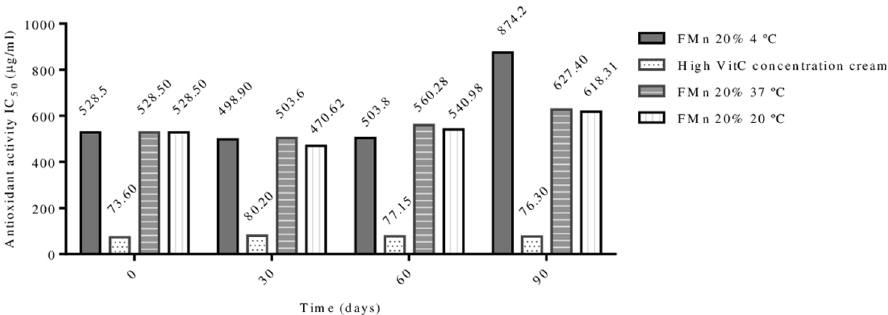
Figure 5. Mean values and standard deviations (Mean ± SD) (number of observations, n = 3) of the antioxidant activity IC 50 ( µ g/mL) over time (t = 0, 30, 60, and 90 day) and at distinct temperatures (T = 4, 20, and 37 ◦ C), in the base-emulsion and the emulsion containing a 20% extract of Morus nigra . Table 2. Mean values of the antimicrobial activity of crude hydroalcoholic extract of Morus nigra L. in the base emulsion and in emulsions containing the extract. n =